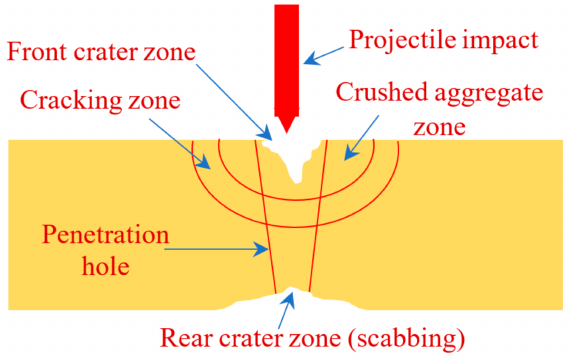
Figure 18. Failure mechanism of specimen under repeated